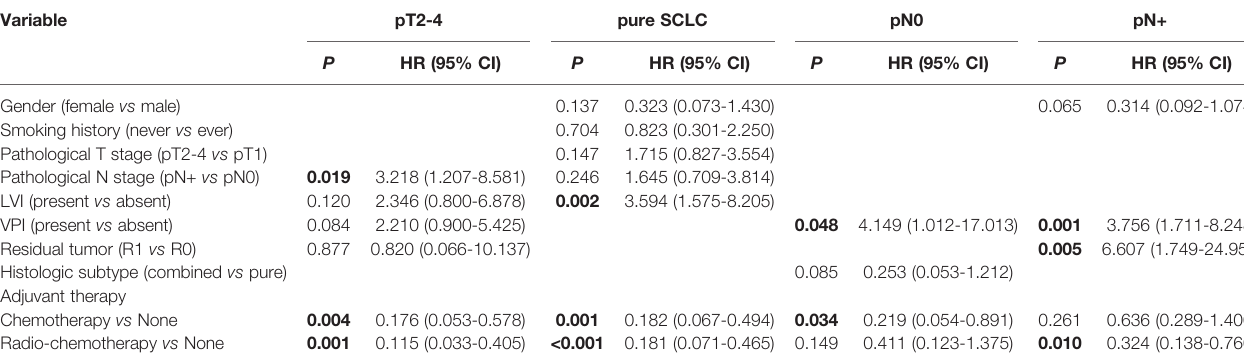
TABLE 3 | Multivariate analysis of factors associated with overall survival for surgically resected SCLC patients with pT2-4 (n=76), histologic pure SCLC (n=108), pN0 disease (n=70) and pN+ disease (n=83). Variable pT2-4 pure